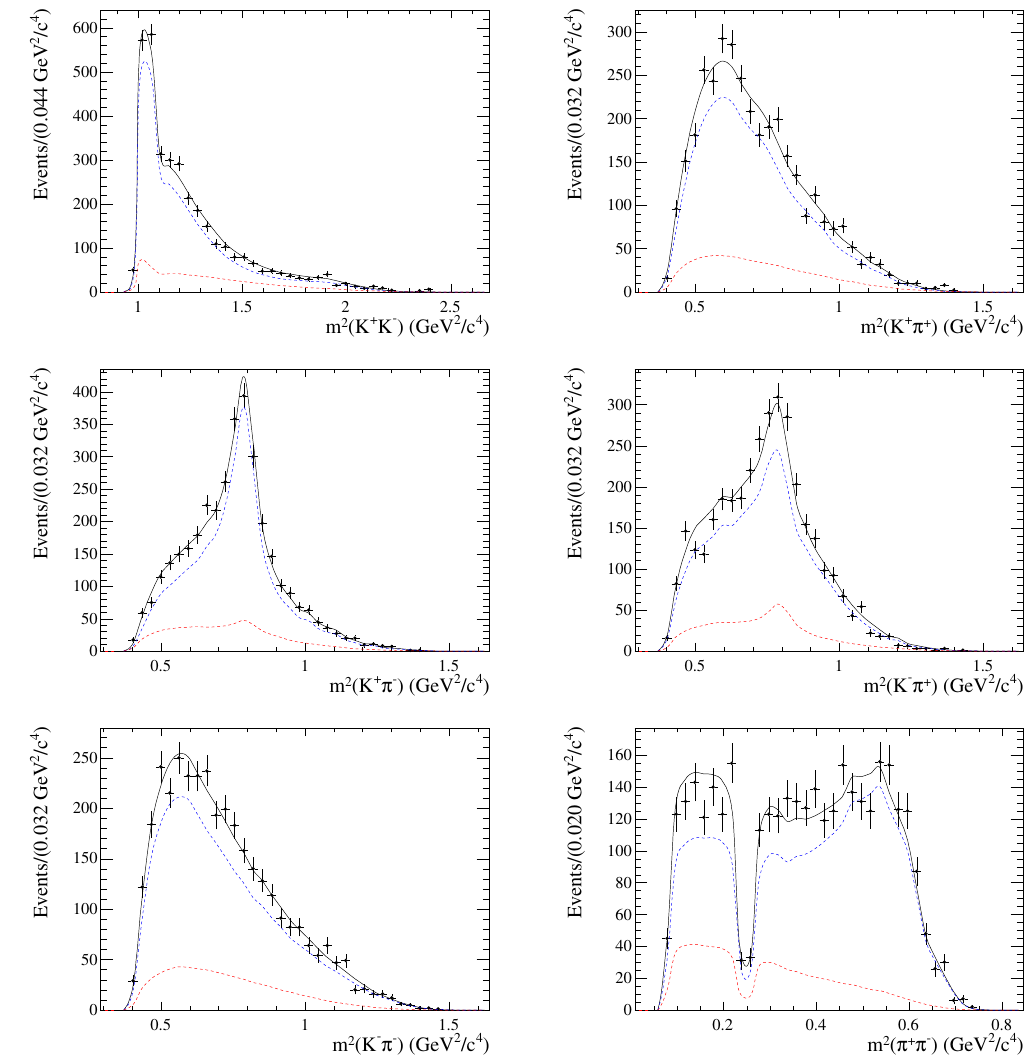
Figure 11 . Invariant 2-body mass distributions of D 0 ! K + K (cid:0) (cid:25) + (cid:25) (cid:0) signal candidates shown as points with error bars. The overall (cid:12)t projection is shown in black, the signal in blue and the background in red. The e(cid:11)ect of the K 0 veto can clearly be seen in the bottom right S